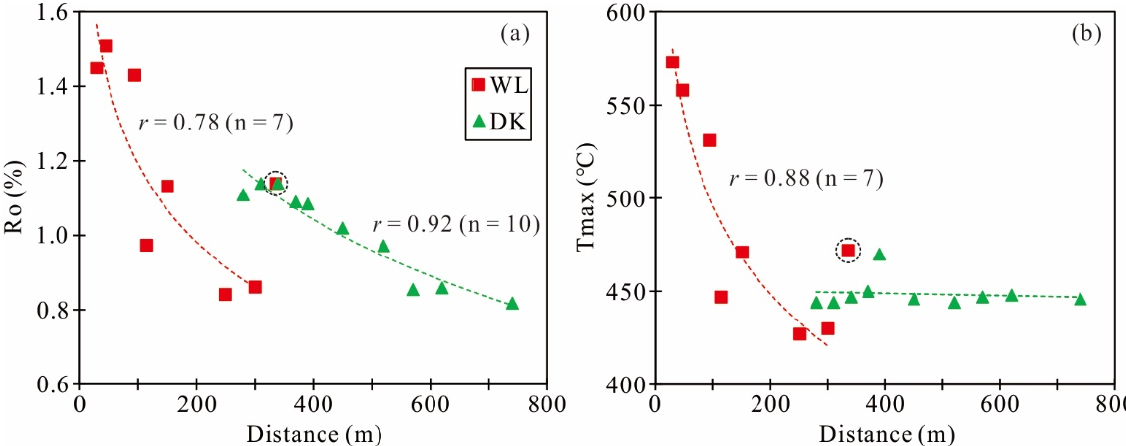
Figure 8. Cross plot of Ro ( a ) and Tmax ( b ) versus distance from the granite porphyry dike.